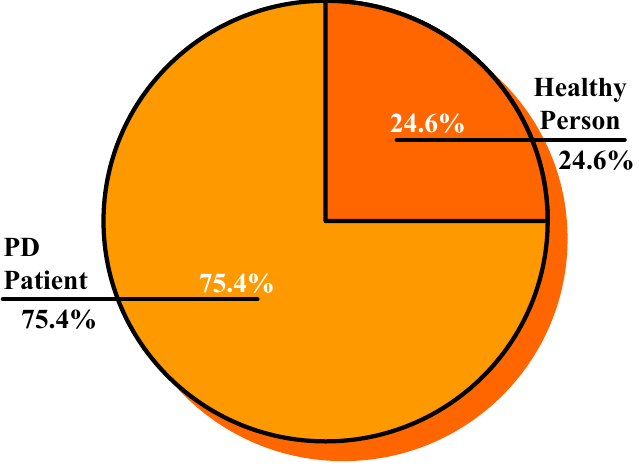
Figure 3. Health Status of PD Patient.